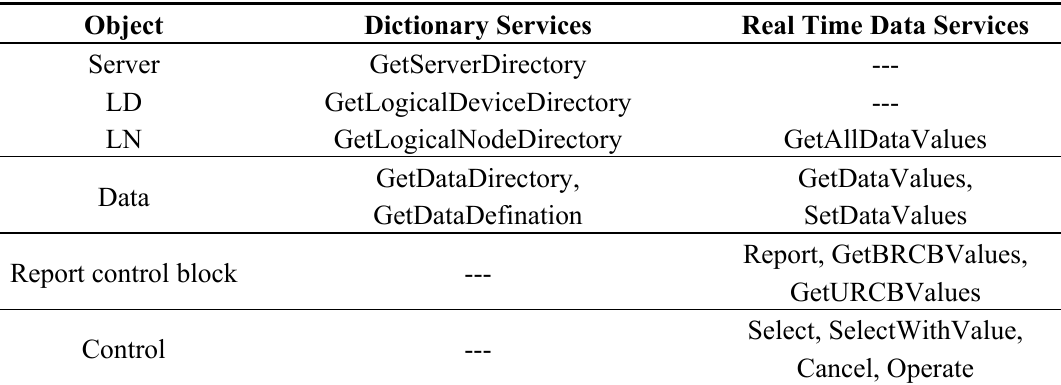
Table 1. Dictionary/real time data